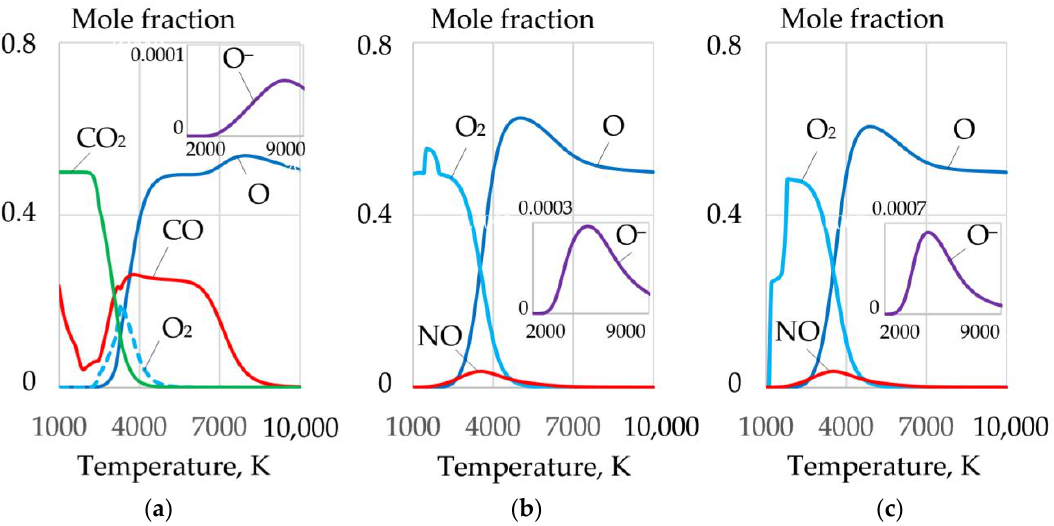
Figure 8. Mole fractions of gases and negative ions of oxygen O − during dissociation of salts: ( a ) FeCO 3 ; ( b ) NaNO 3 ; ( c ) KNO 3 .